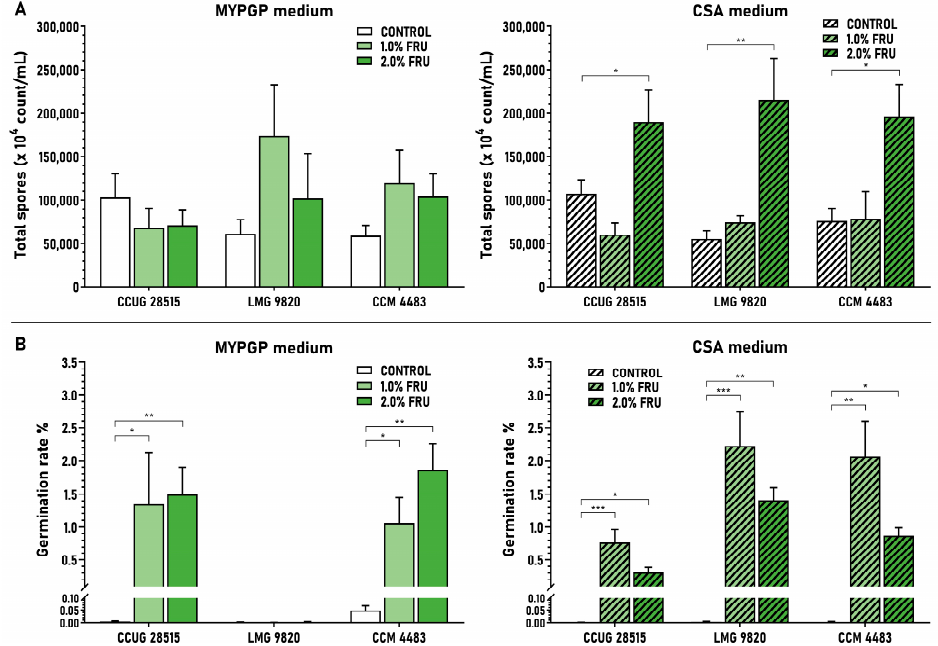
Figure 5. Effect of fructose on total spore production ( A ) and spore germination ( B ) of P. larvae strains with an ERIC I genotype. Data are expressed as the mean ± SEM. Data showing statistical significance are marked (* p < 0.05, ** p < 0.01, *** p < 0.001). Individual data sets represent results from 4–6 spore cultivation replicates. Spore germination rates were determined as the percentage of viable spores (grown on MYPGP plates supplemented with germination factors) to total spores (microscopically determined) present in the spore cultures.